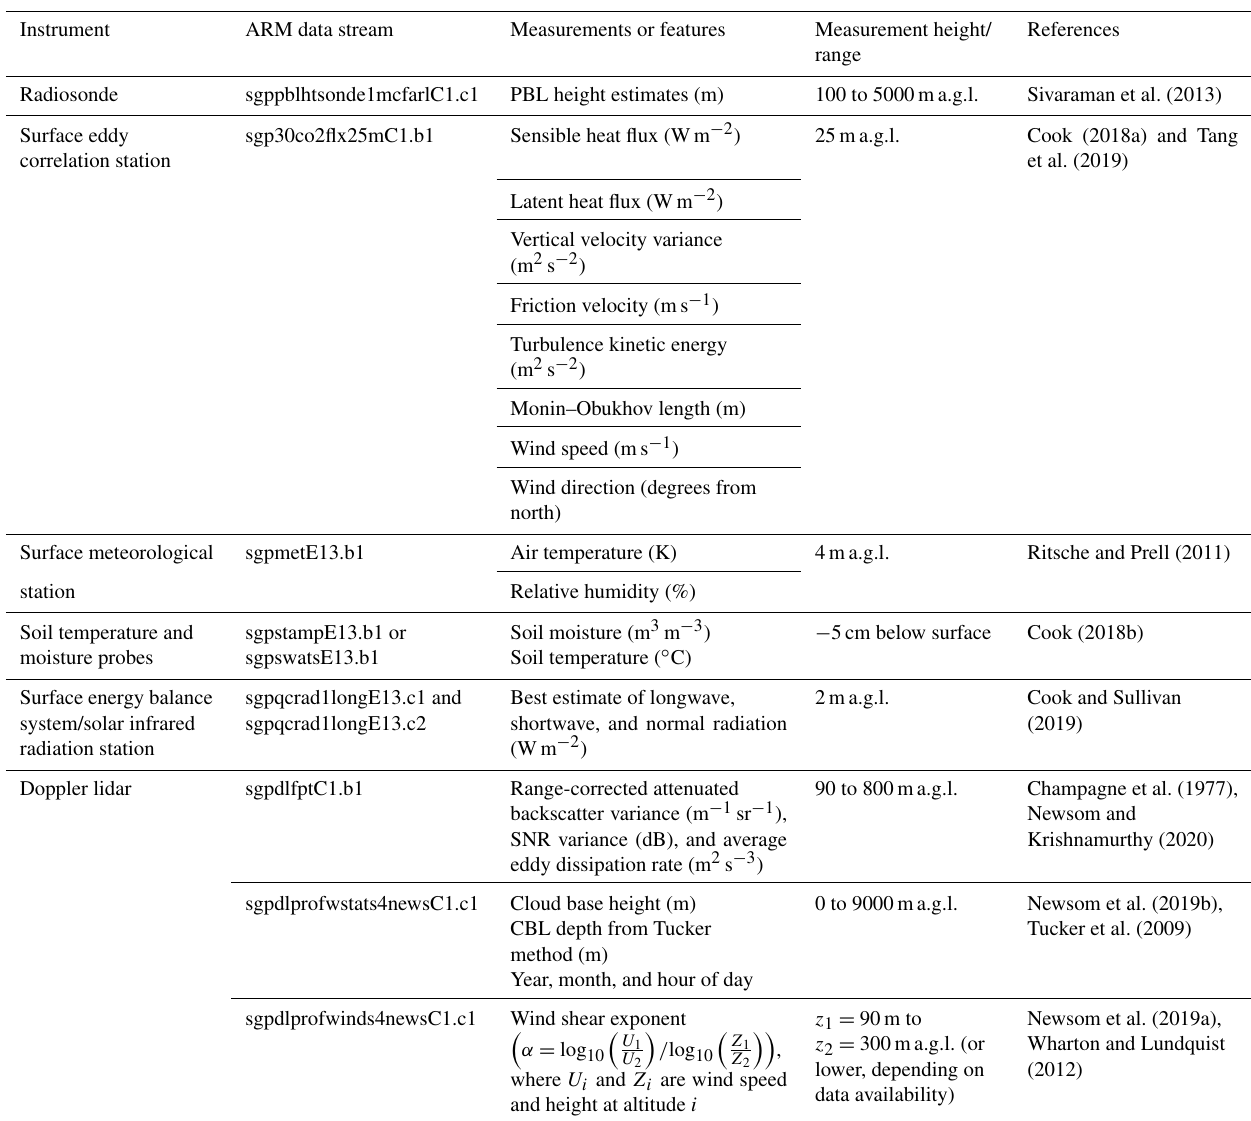
Table 1. Instruments, ARM data stream names, and measurements used in this